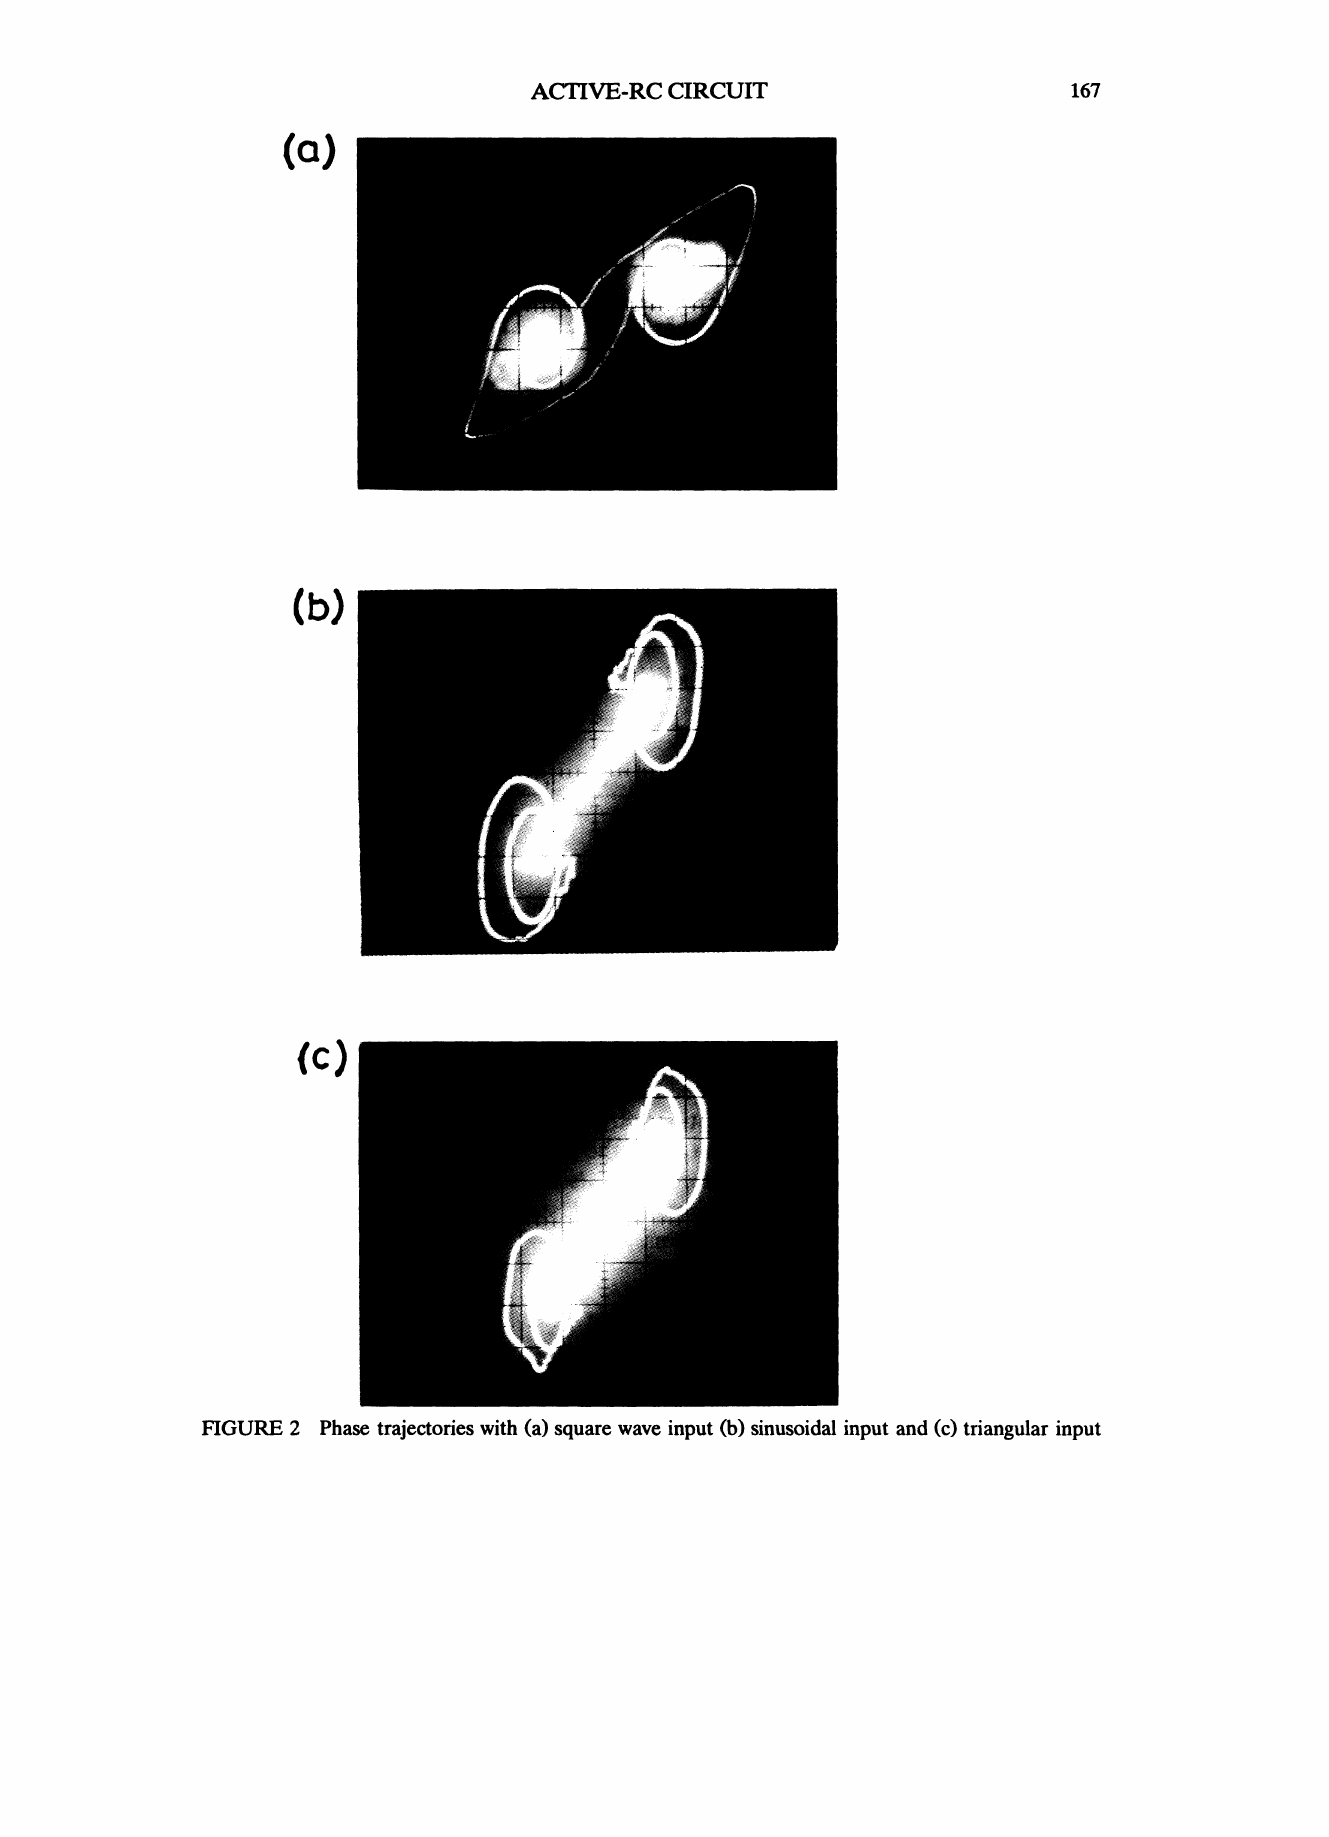
FIGURE 2 Phase trajectories with (a) square wave input (b) sinusoidal input and (c) triangular